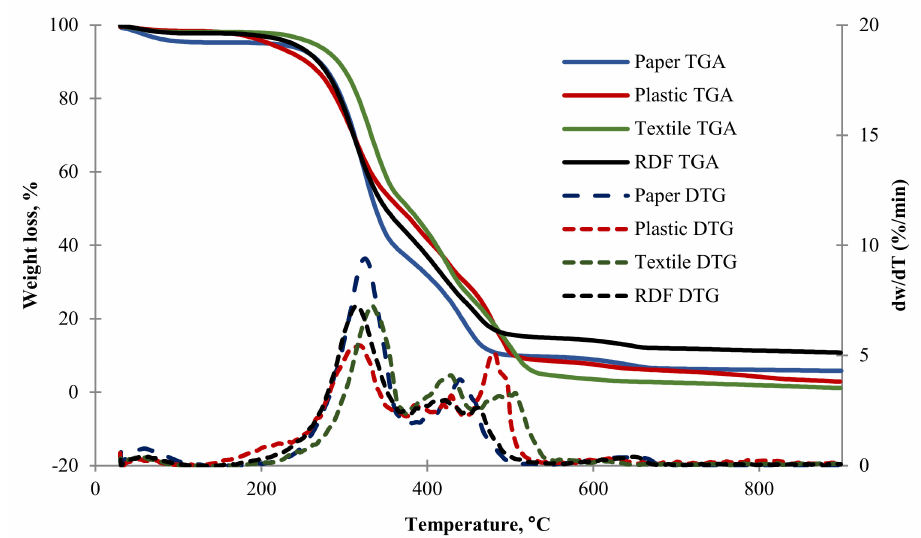
Figure 4. Weight loss curves (TG) and weight loss rates (DTG) of samples at 10 ◦